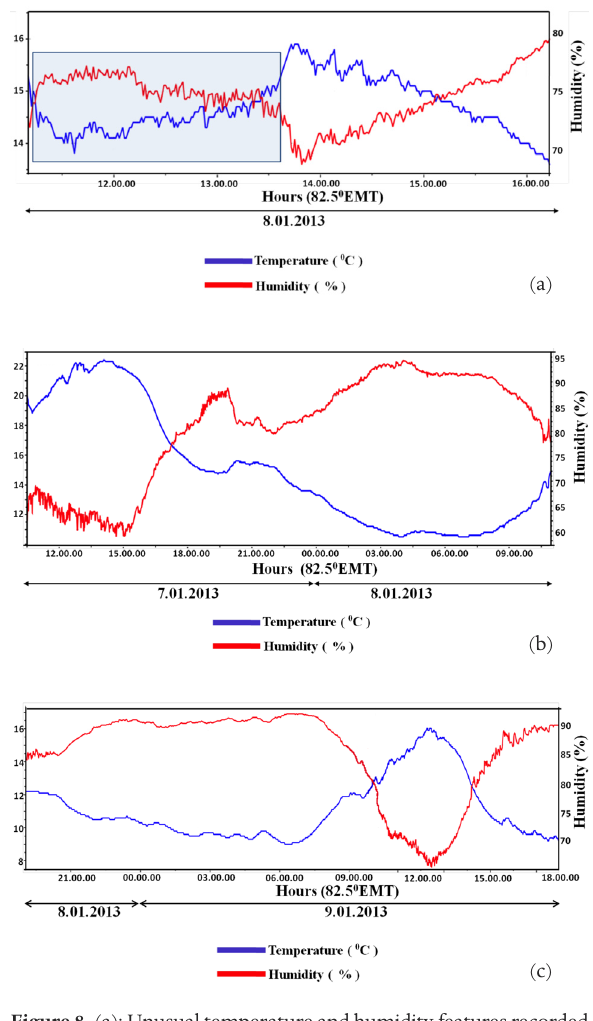
Figure 8. (a): Unusual temperature and humidity features recorded at GU during 1100 hours to 1630 hours of January 8, 2013, a day prior to the January EQ event. The sudden drop in temperature at 1130 hours, 82.5° EMT is to be noted along with the increase in hu- midity. These anomalous features are marked within a box in the temperature/humidity plot. (b) and (c): Normal variations in tem- perature and humidity a day preceding (1100 hours, 82.5° EMT of January 7 to 1000 hours, 82.5° EMT of January 8) and a day after (1800 hours, 82.5° EMT of January 8 to 1800 hours, 82.5° EMT of January 9) the unusual event recorded on January 8.